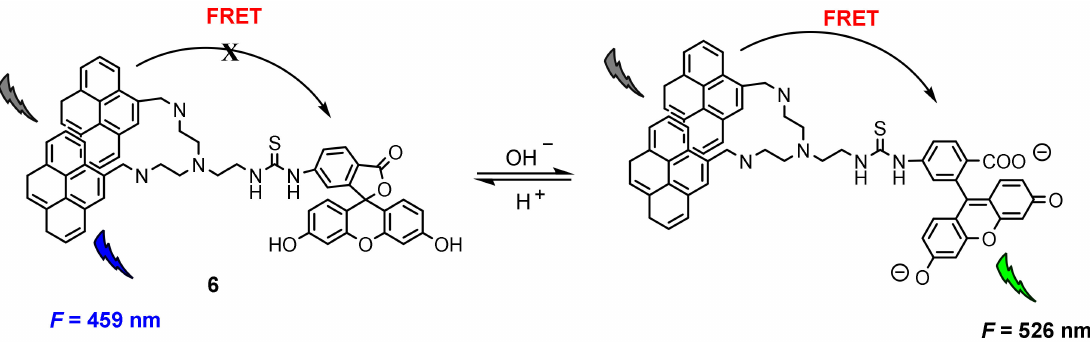
Figure 15. Chemical structure of probe 6 and its response to